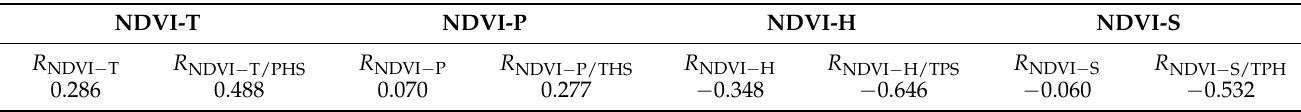
Table 4. Correlation coefficient between NDVI and climatic factors in the middle reaches of the Yangtze River (MRYR) from 1999 to